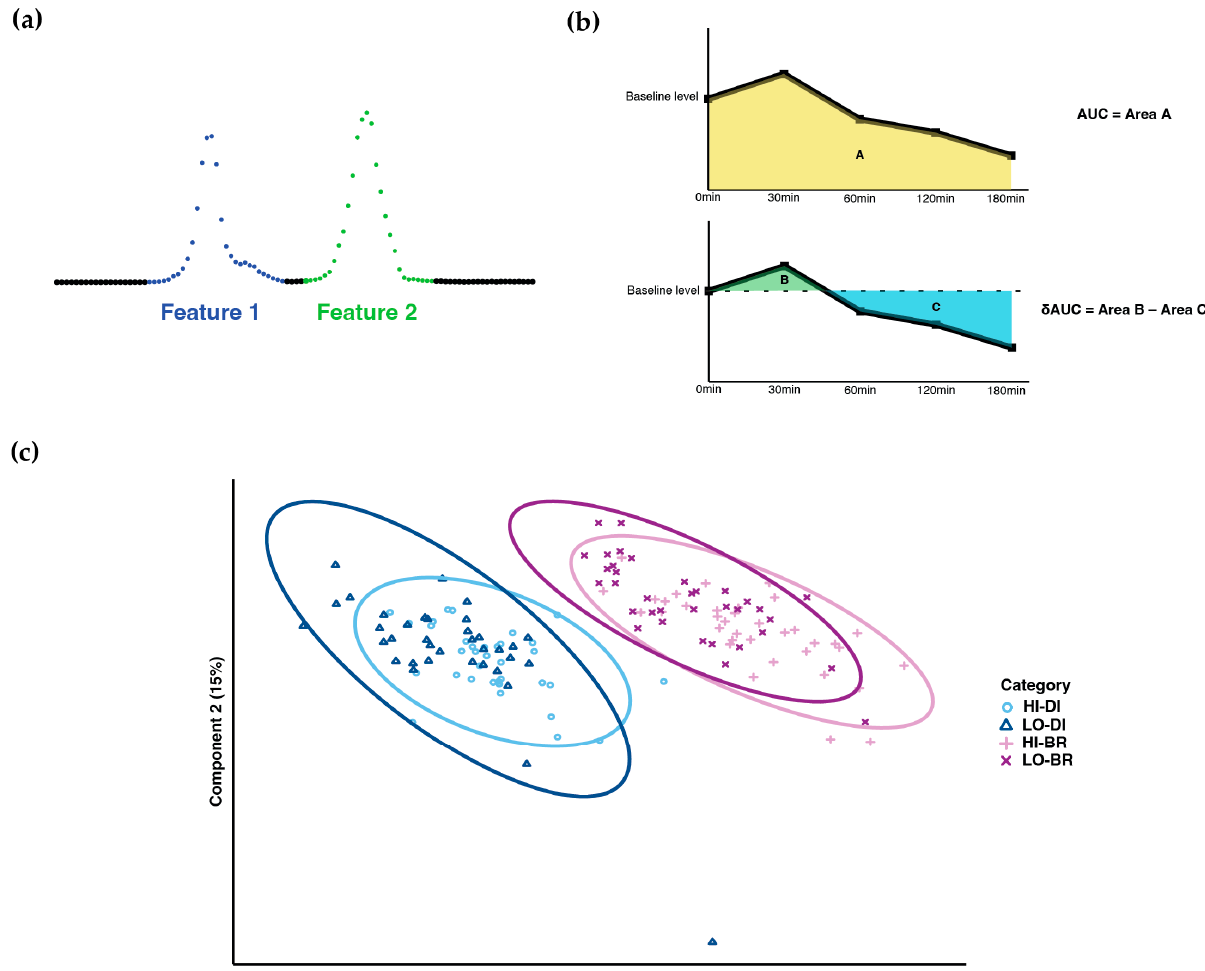
Figure 1. Metabolome profiling. ( a ) Naming methodology of metabolites with multiple peaks. ( b ) Calculation of AUC and δ AUC. ( c ) PLS-DA result of sample clustering (HI-DI: high-GI